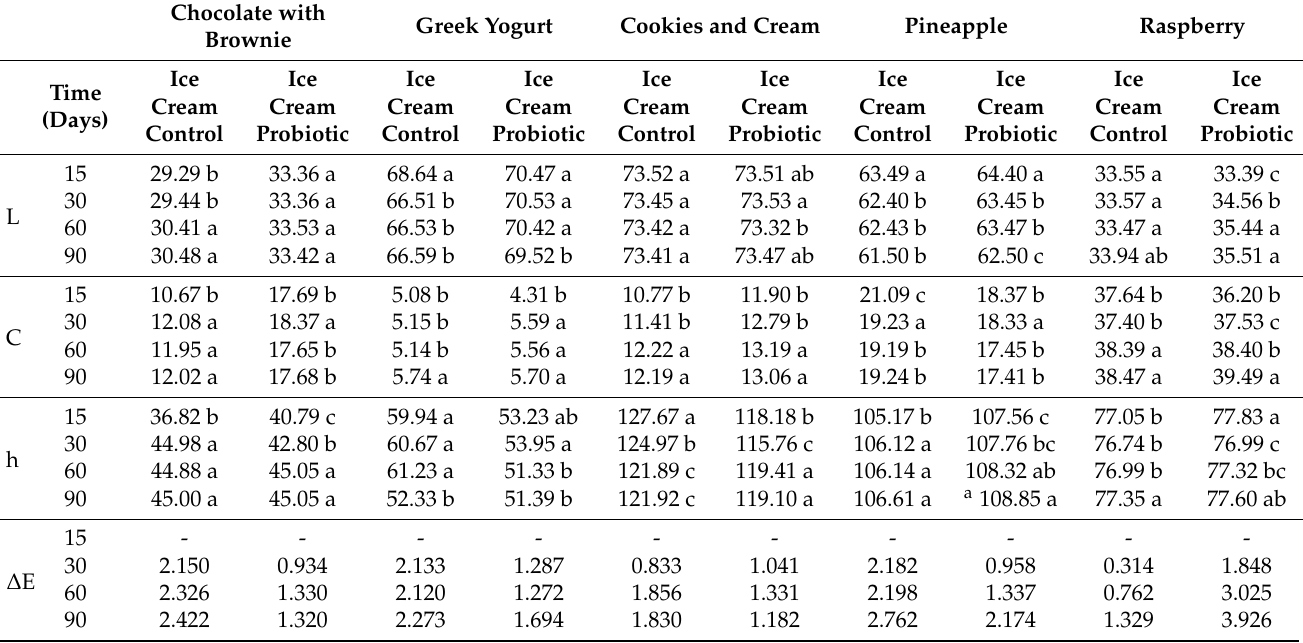
Table 5. Color parameters variables in the control and probiotic ice creams supplemented with L. fermentum